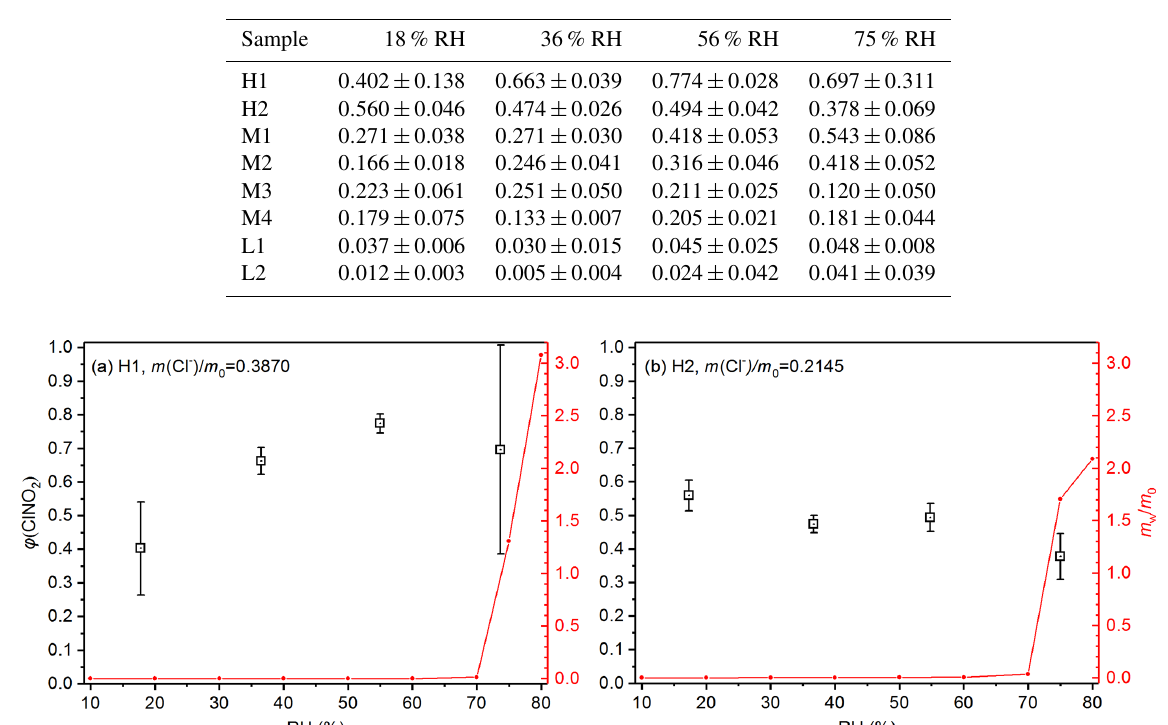
Table 2. Measured ClNO 2 yields for heterogeneous uptake of N 2 O 5 onto saline mineral dust samples at different RH levels. All the errors given in this work are standard deviations. The uncertainty in RH was ± 2%.